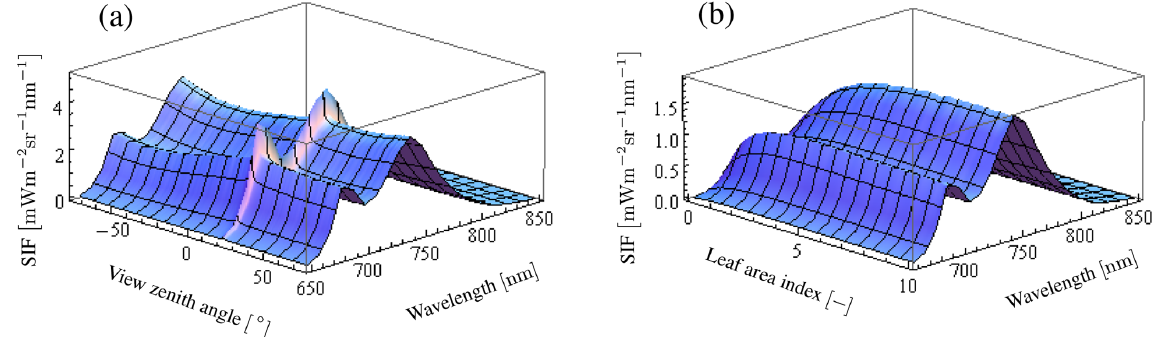
Figure 9. Variation of SIF radiance depending on VZA and LAI in the wavelength of 650 to 850nm. Panel (a) indicates VZA dependence of SIF at LAI of 3.0 and SZA of 20 ◦ . There is a strong peak in the Sun direction at the whole wavelength. Panel (b) indicates LAI dependence of SIF at VZA of 0 ◦ and SZA of 20 ◦ . SIF radiance increases with LAI and then becomes